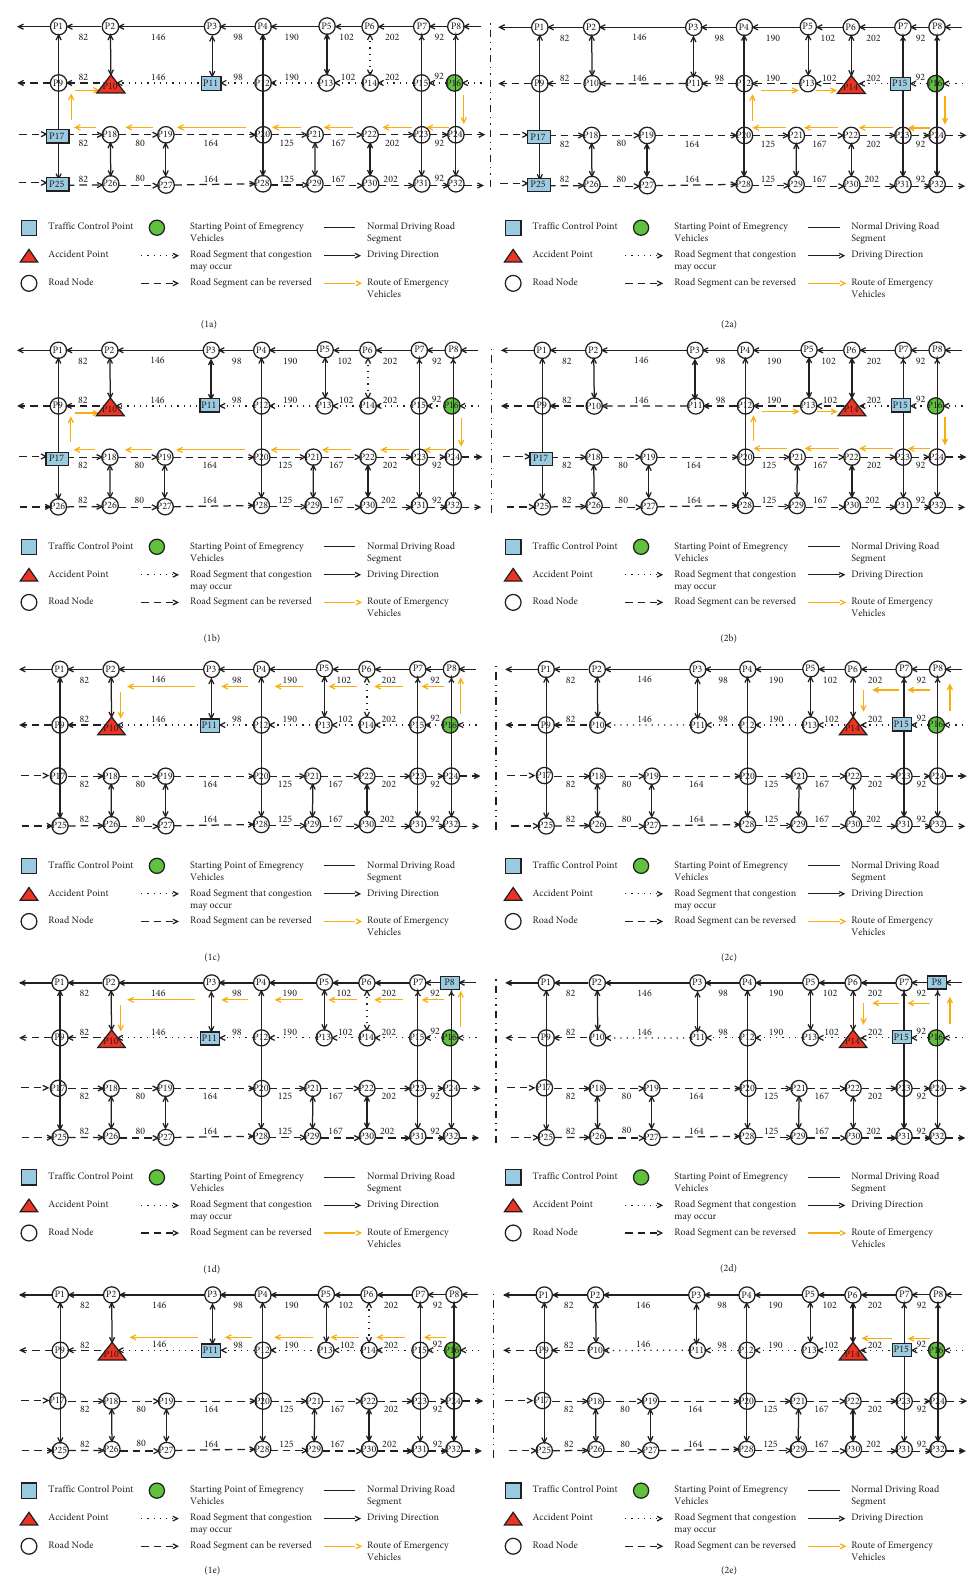
Figure 3: Abstracted schematic diagram of road segment model and optimal rescue path planned by PERDQN and SP method. (1a) Optimal rescue path planned by PERDQN in case 1 under scheme 1. (2a) Optimal rescue path planned by PERDQN in case 2 under scheme 1. (1b) Optimal rescue path planned by PERDQN in case 1 under scheme 2. (2b) Optimal rescue path planned by PERDQN in case 2 under scheme 2. (1c) Optimal rescue path planned by PERDQN in case 1 under scheme 3. (2c) Optimal rescue path planned by PERDQN in case 2 under scheme 3. (1d) Optimal rescue path planned by PERDQN in case 1 under scheme 4. (2d) Optimal rescue path planned by PERDQN in case 2 under scheme 4. (1e) Optimal rescue path planned by SP in case 1. (2e) Optimal rescue path planned by SP in case